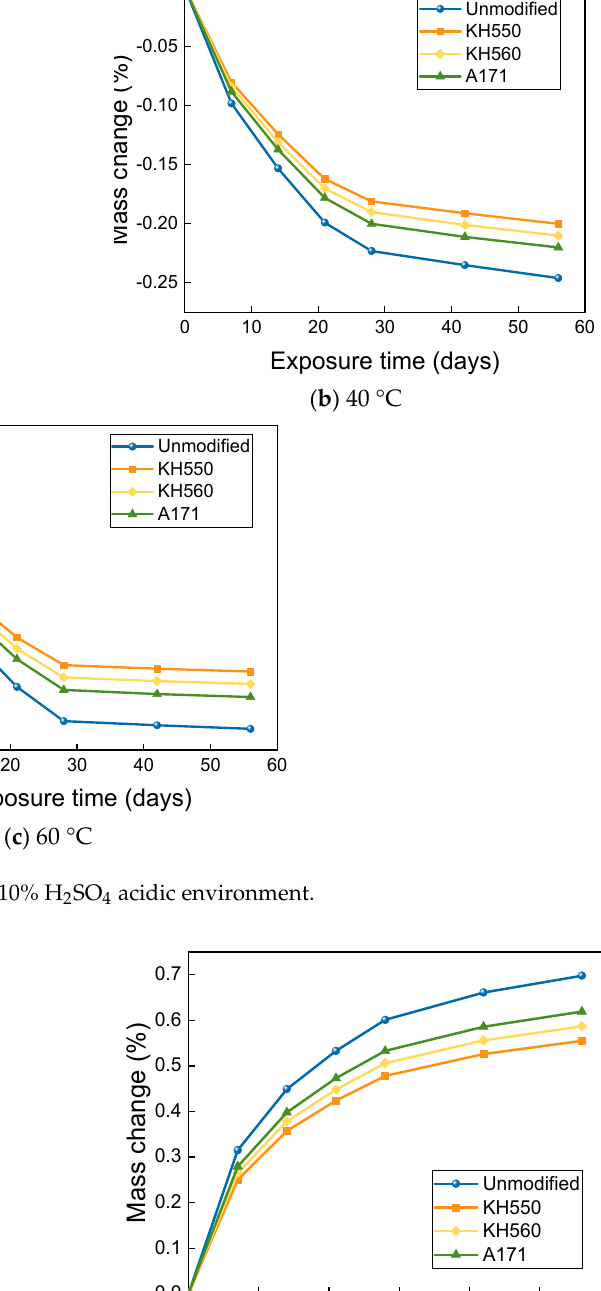
moisture uptake, which leads to greater weight gain. Similar results were reported by Karbhari and Chu [38], who compared the weight gain of glass/vinyl ester composites submerged in different solutions. When the composite samples were submerged in water, seawater, and alkaline solutions, the water molecules in these solutions penetrated the composites, increasing the mass of the samples.